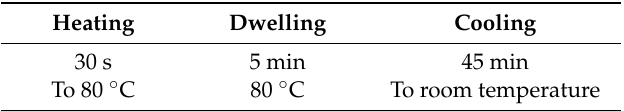
Table 2. Microwave heating program for the MIL-88(A) NPs synthesis. Heating